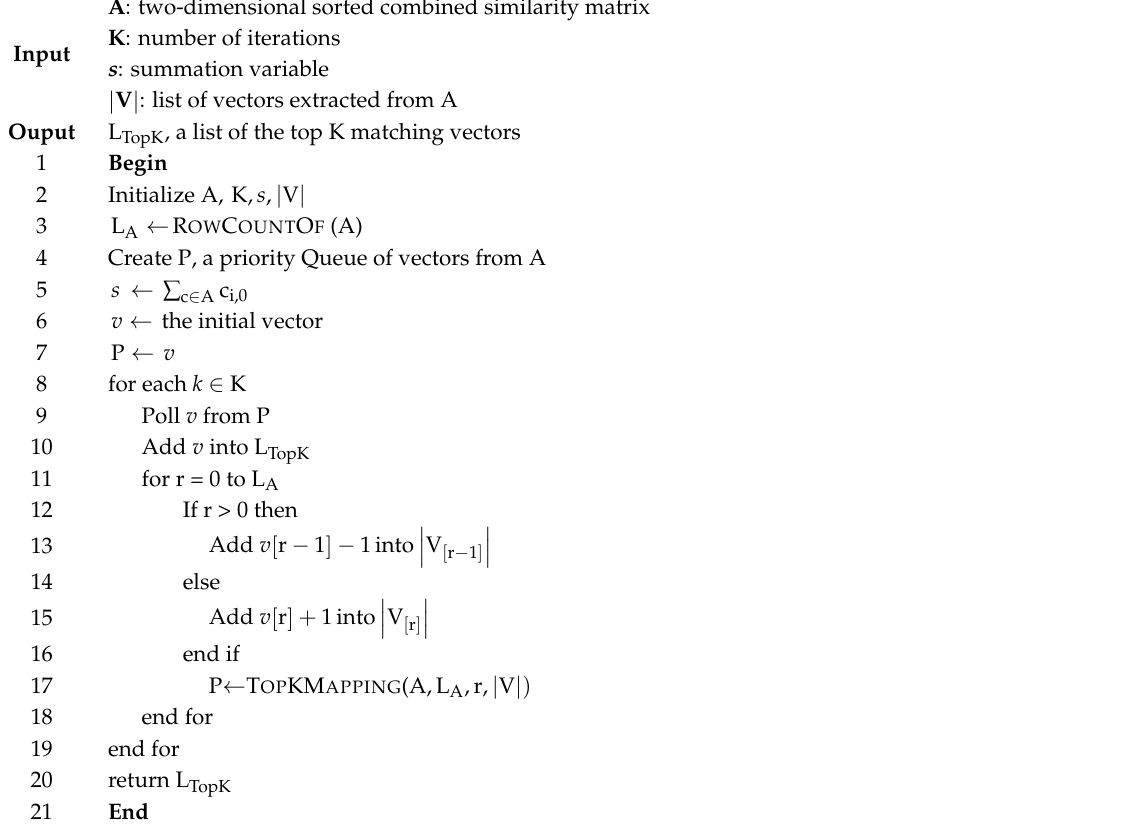
Algorithm 4 Top-K Candidates.